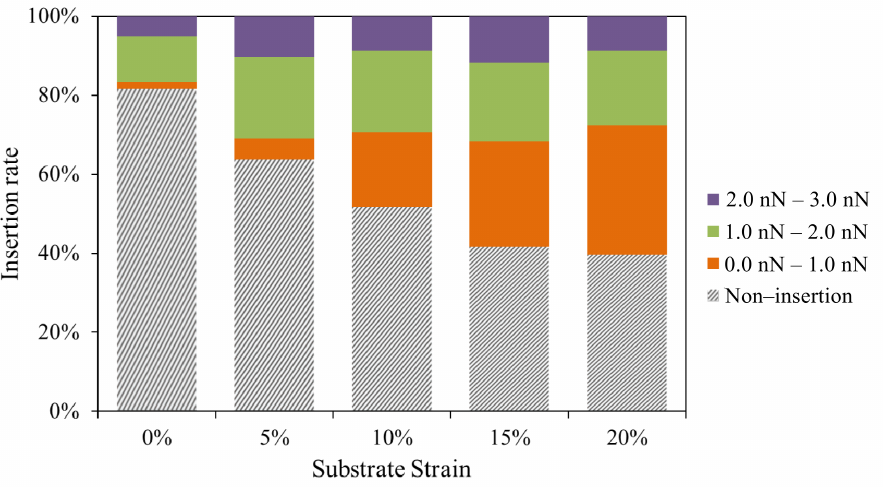
Figure 8. The statistical analysis of the insertion rate under different substrate strains and insertion force